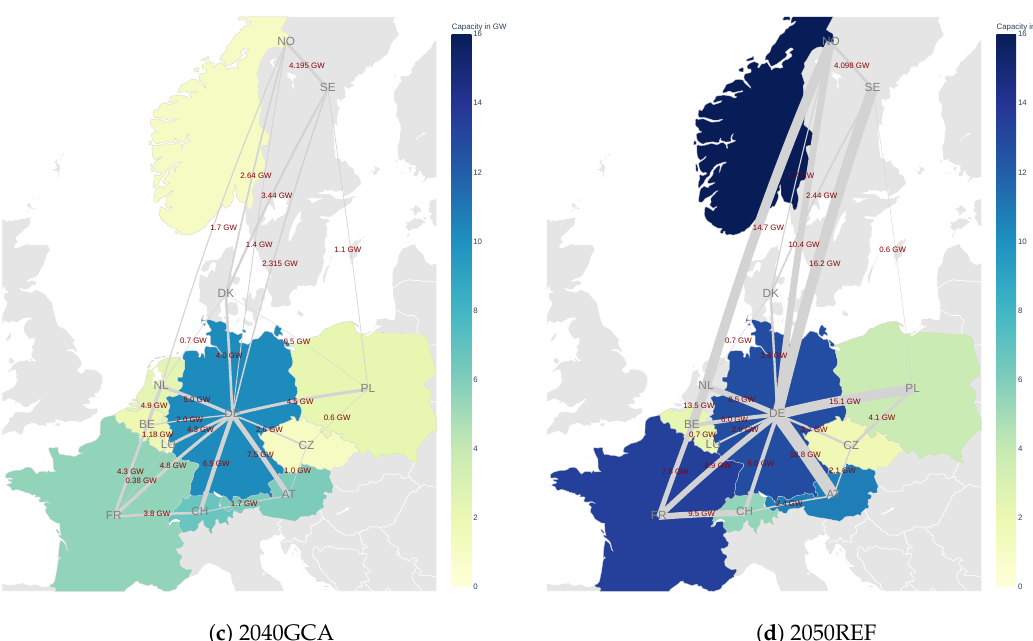
Figure A2. Transmission and PHS storage capacities. Countries are dyed based on their installed PHS capacity in each scenario. The 2050 scenario is based on the e-Highway2050 [29] 100% RES scenario. All other scenarios are based on the TYNDP2018